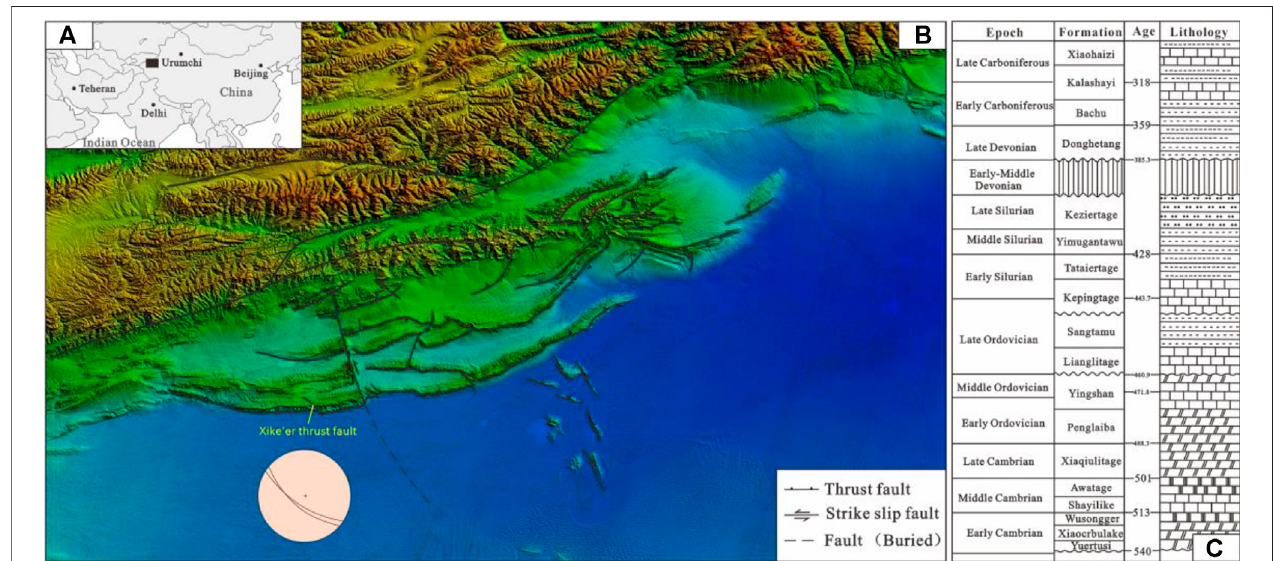
FIGURE1| LocationandgeologicalmapandlithologicaloftheAkesu-KepingareainTarimBasin. (A) RegionallocationmapoftheTarimBasin. (B) 3Dtopographic mapoftheAkesu-Kepingarea,theXike ’ erfaultislocatedinthewestofthePiqiangfault,whichisaNWreversefaultwithasteepdipof83 ° ,andthesurroundingstrataare mainlyCambrian, OrdovicianandSilurian. (C) Lithologichistogram ofTarimBasin.Itcanbefoundinthebar chartthattheoutcroppingstrata inthestudyareaaremainly carbonate strata.